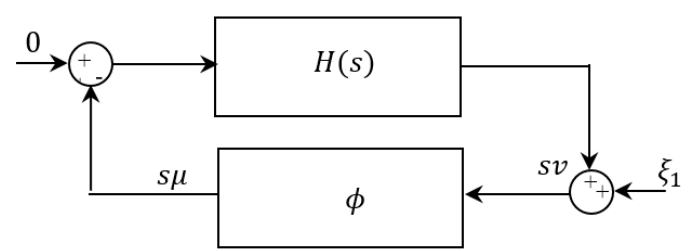
Figure 7. Nonlinear feedback relating the derivatives of calculated and constrained control signals.